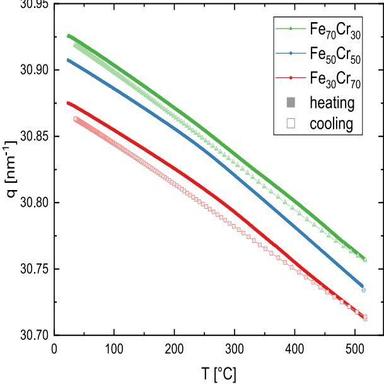
peak position for every pattern during heating (full symbols) and cooling (empty symbols) for HPT-deformed FeCr alloys determined by fitting the HEXRD in situ data by a single Voigt profile. The cooling is not covered experimentally for the Fe50Cr50 alloy.